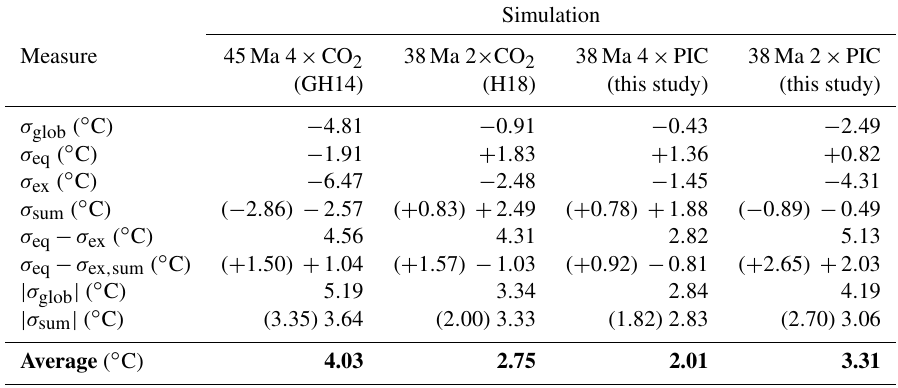
Table 4. Model skill scores following a procedure comparable to the one presented by Lunt et al. (2012) for the model results of GH14, H18, and those presented here using the 42–38Ma SST proxy compilation from Fig. 6 (see also Table S3). The last column considers the 38Ma 2 × PIC case and 38–34Ma SST proxies (see Fig. S10 and Table S4). Different measures are used (top to bottom): global, equatorial ( < 23 . 5 ◦ N or S), extra-tropical ( > 23 . 5 ◦ N or S), summer temperatures (only for > 23 . 5 ◦ N or S), meridional temperature gradient (i.e. equatorial and extra-tropical; annual or summer), global absolute error, and summer absolute error. Bracketed values indicate model skill using modelled summer temperatures only when they improve agreement with the corresponding proxy estimate. An average skill score for each model–proxy comparison is also determined by taking the root mean square of all the above measures and highlighted in